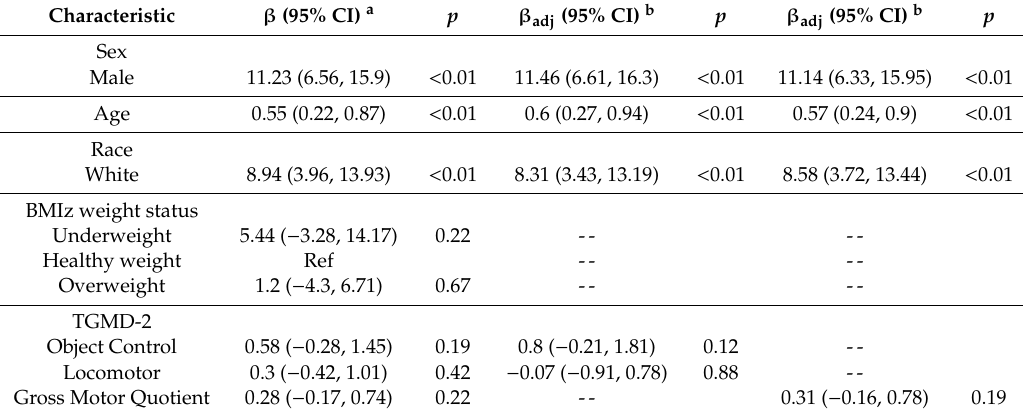
Table2. Unadjustedandadjustedlinearassociationsofgrossmotordevelopmentandchilddemographic characteristics with mean minutes of moderate-to-vigorous physical activity per day.